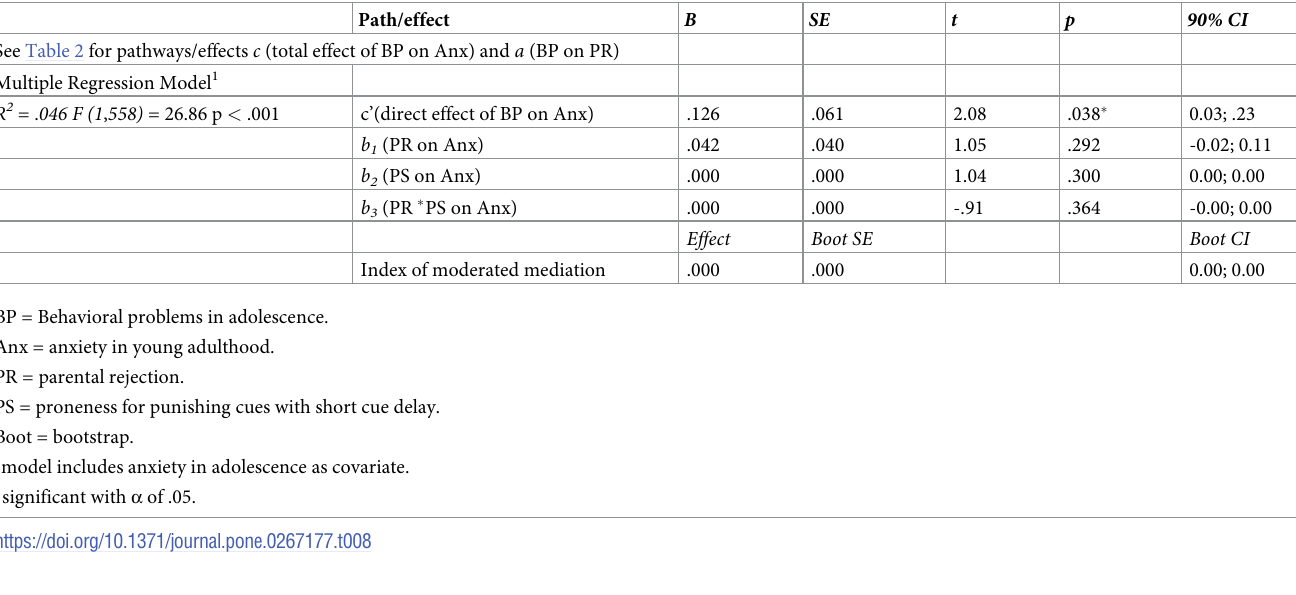
Table 8. Moderated mediation analysis for the association between behavioral problems in adolescence and anxiety in young adulthood via parental rejection, mod- erated by punishment